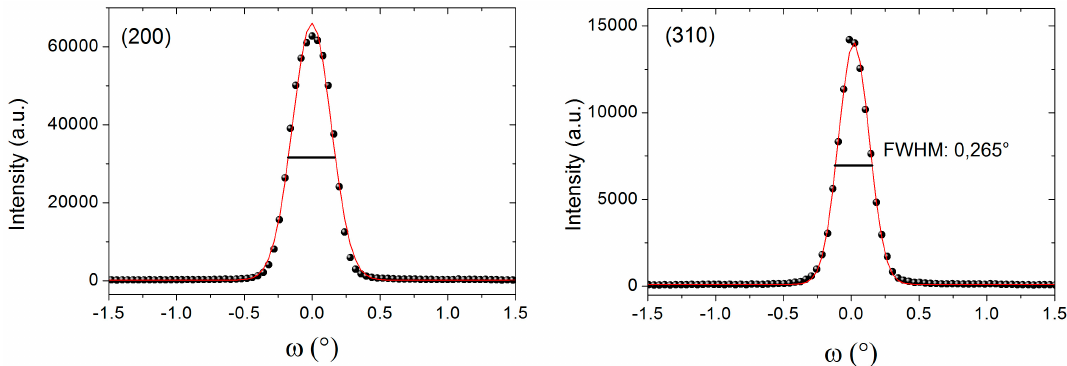
Figure 5. Rocking curves of the (200) and the (310) reflections for c-SSGO, crystal giving evidence of the excellent quality and good mosaicity of the grown single-crystal. FWHM: full width half maximum.